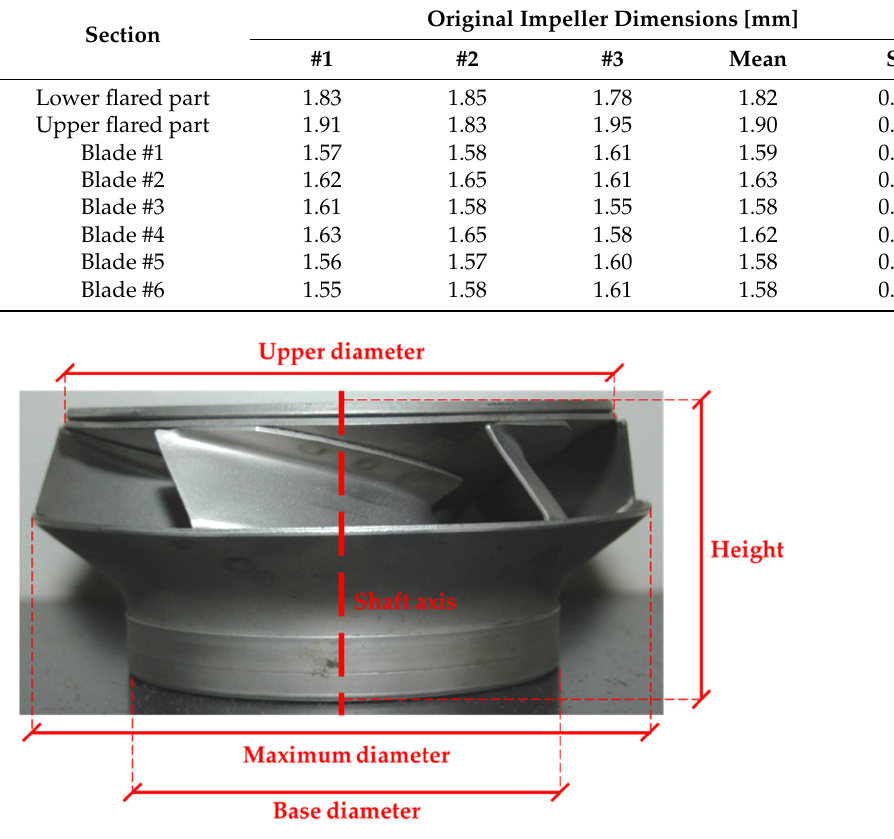
Figure 3. Main dimensions of the impeller of the SP 215 pump. Table 2. Thickness values of the sections constituting the original impeller by Grundfos measured on three random points (indicated as #1, #2 , and #3 for sake of simpleness). All of the values are expressed in mm. “Std” stands for standard deviation.